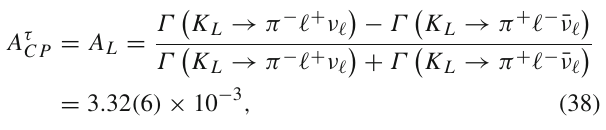
one to distinguish among them once data on A FB ( s ) become